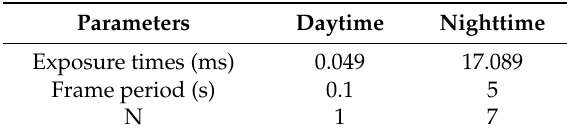
Table 2. Relationship between exposure time and frame period of daytime and nighttime imagery of LJ1-01.